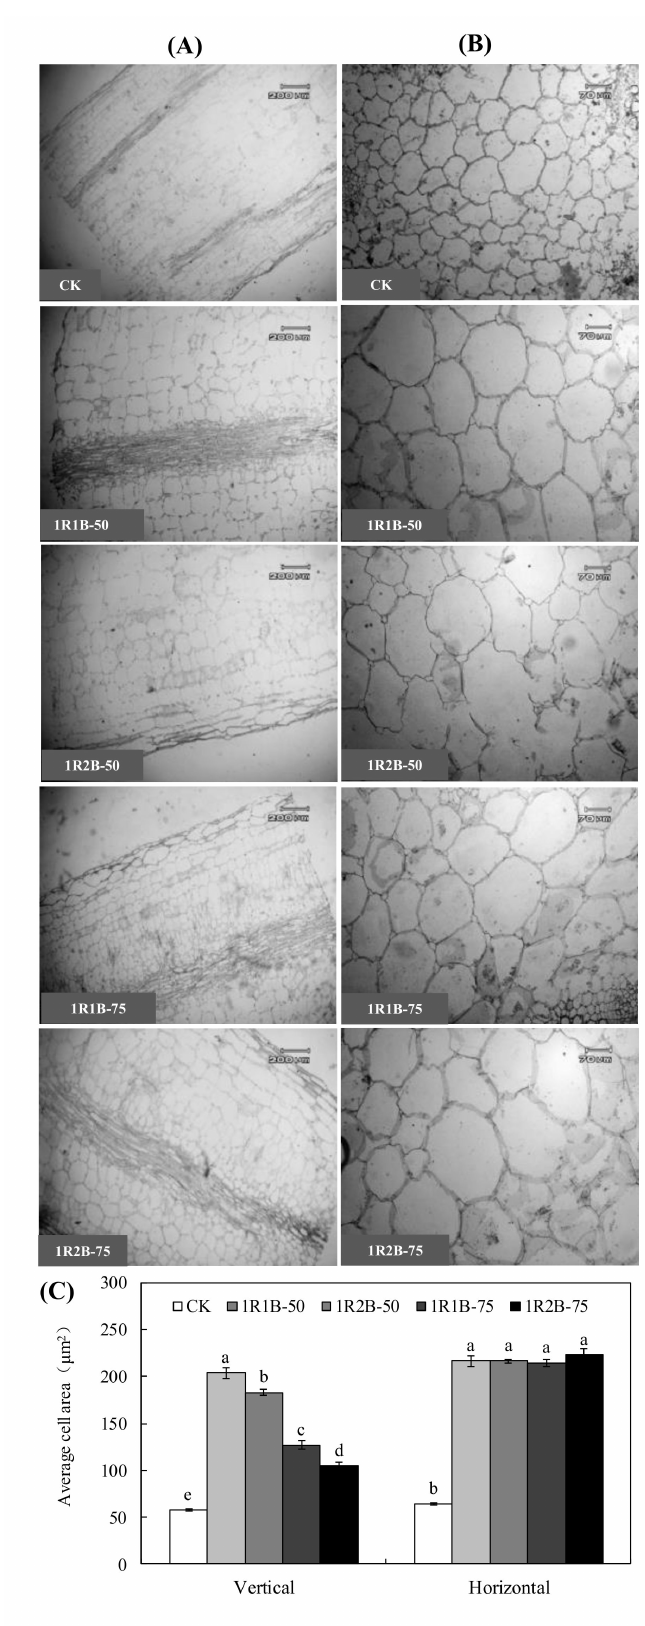
Figure 7. Microstructure from hypocotyl cells in cucumber seedlings grown under di ff erent light treatments. Vertical cut 40 × ( A ), horizontal cut 100 × ( B ), average cell area ( C ). Di ff erent letters indicate statistically significant di ff erences among treatments (ANOVA, p ≤